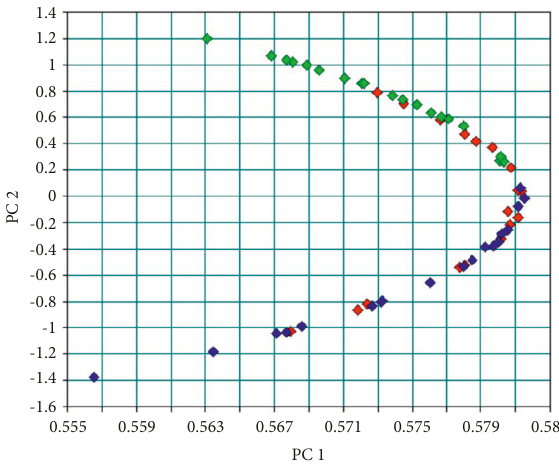
Figure 3: Scores of DFD cocoa samples.